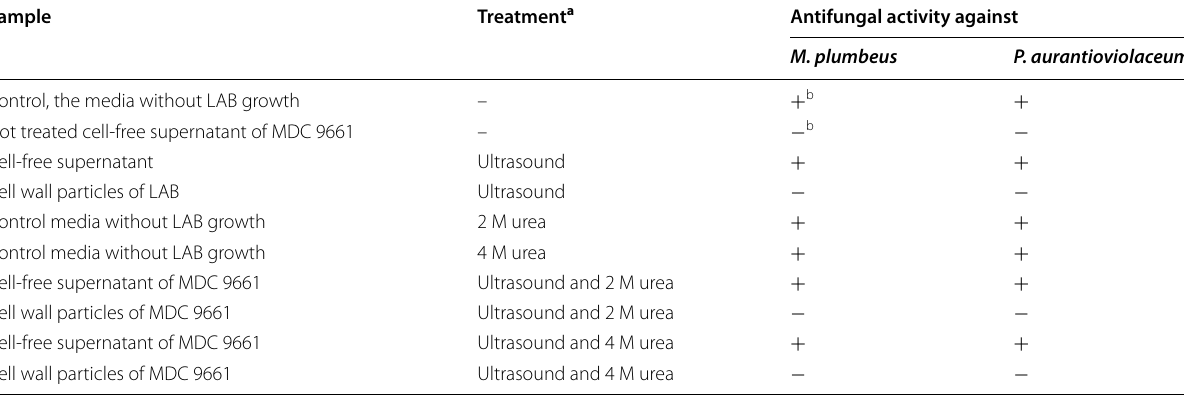
Table 2 The residual antifungal activity of L. rhamnosus MDC 9661 after the treatment with ultrasound and 2 and 4 M urea